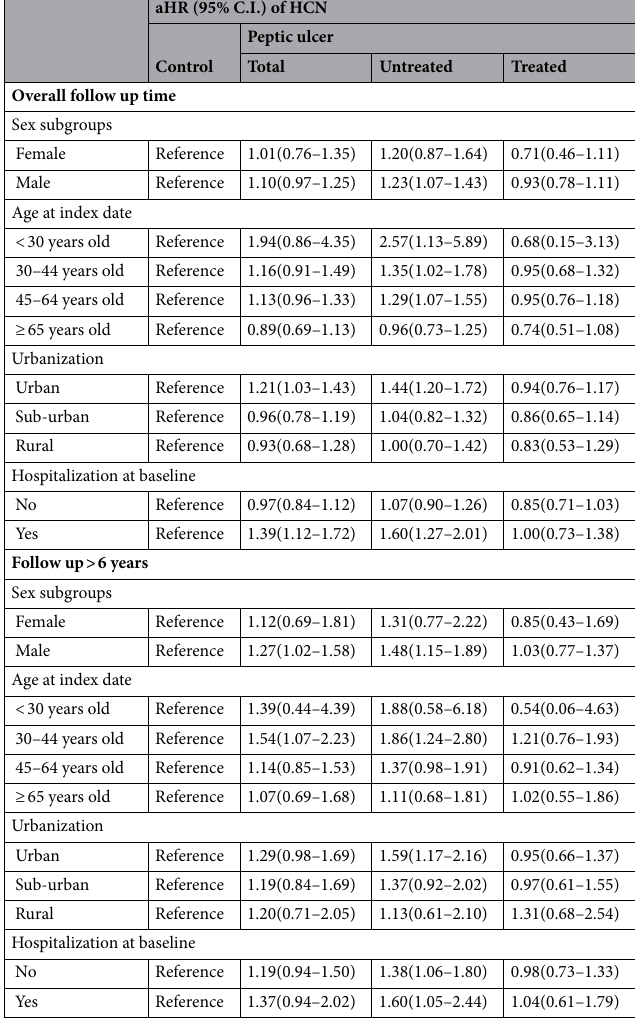
Table 4. The sensitivity analysis for the adjusted hazard ratio (95% C.I.) stratified by follow up time, sex and age groups after PSM. PSM, propensity score matched; HNC, head and neck